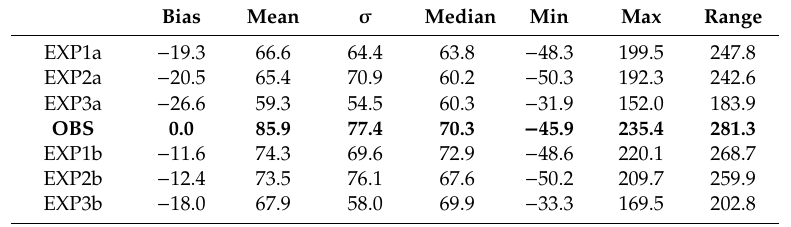
Table 4. Net Radiation (RNET) (W m − 2 ) simulated and observed at CO station (data number 515).